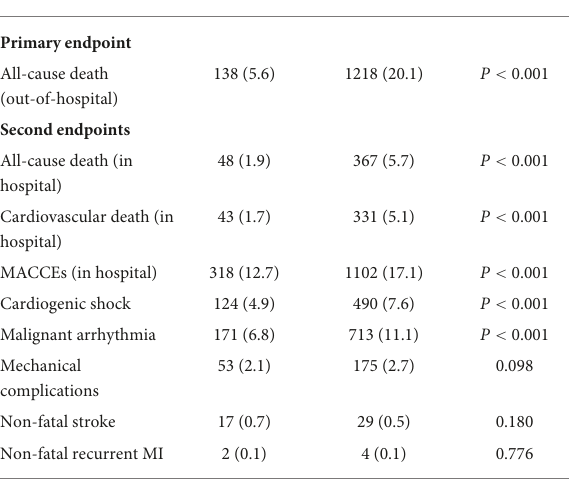
TABLE 2 Comparison of clinical outcomes between the two groups.